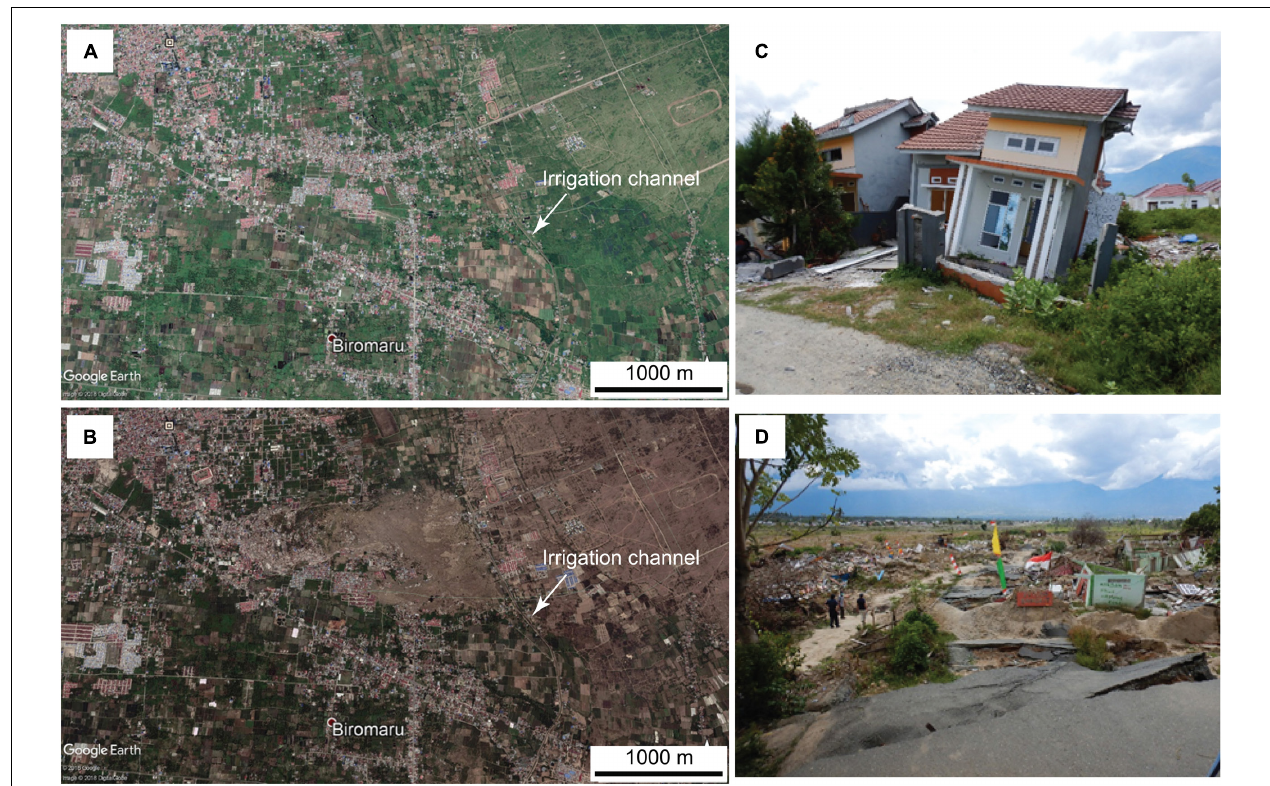
FIGURE 4 | Large-scale landslide at Petobo: (A) Google Earth image before the earthquake, (B) Google Earth image after the earthquake, (C) destroyed houses at the foot of the landslide, and (D) destroyed houses at the crown area of the landslide (point 5 in Figure 2